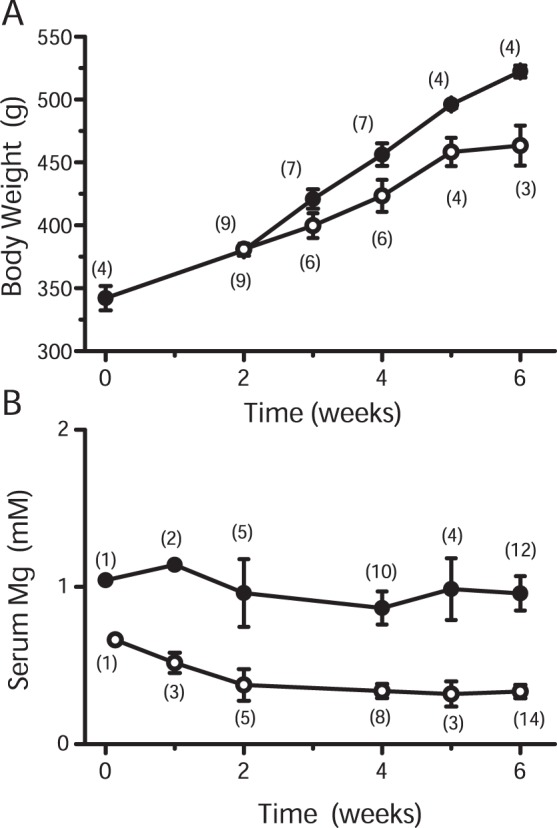
Body weight and serum Mg concentration during Mg-deficiency.Rats (8 weeks old) were divided into two groups and fed either a control diet or a Mg-deficient diet for 1 to 6 weeks. Body weight (A) and total concentrations of serum Mg (B) were plotted as a function of time after either the control diet (filled circles) or the Mg-deficient diet (open circles) was started at time 0. For serum Mg, the small number of data obtained from 4-week-old rats (at the beginning of feeding) was also included, because the serum Mg concentration was similar between the 8-week-old and 4-week-old rats in the pilot experiments. Each symbol represents mean±SEM of the number of rats indicated nearby. For both A and B, the average values of Mg-deficient rats were significantly different from those of control rats (p<0.01, 2-way ANOVA).